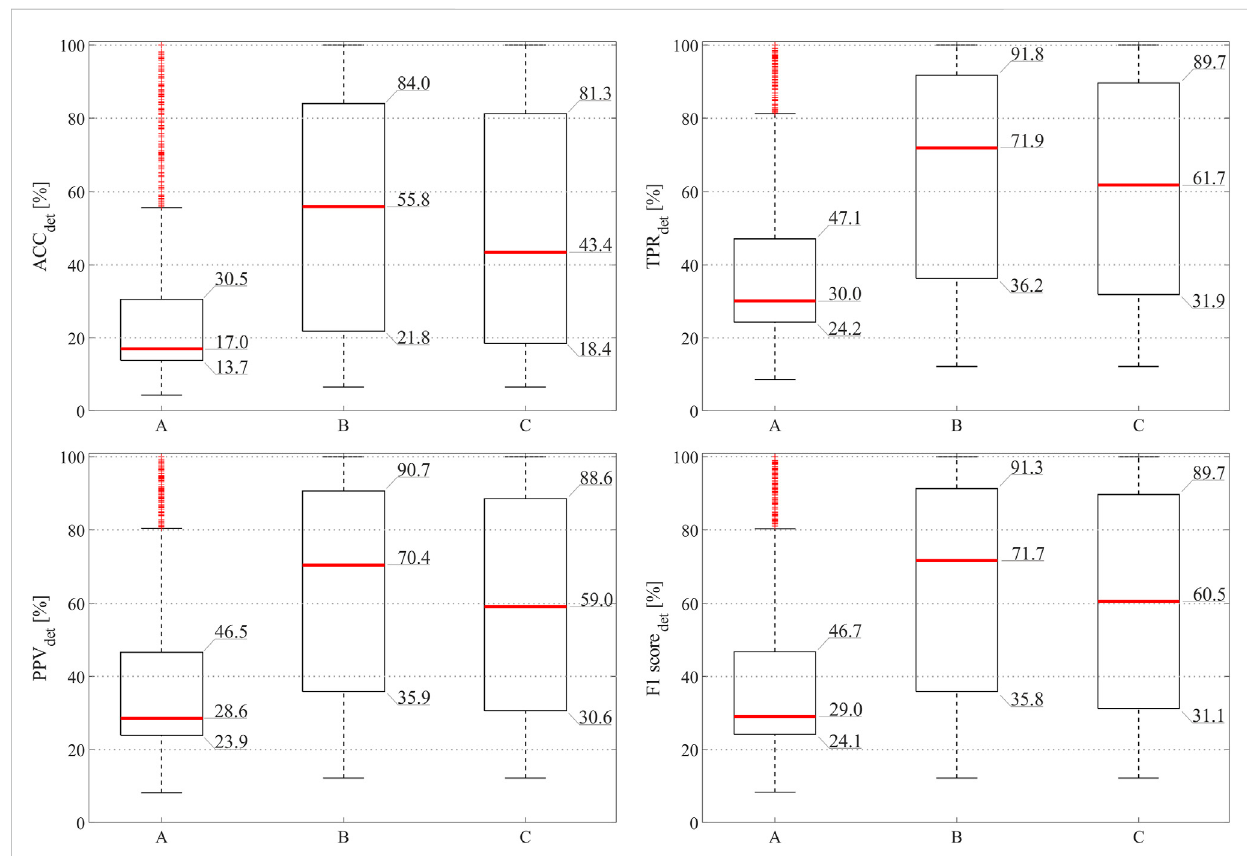
FIGURE 5 Fetal QRS detection results obtained by considering fECG signals extracted by all available abdominal channels (A) , by the abdominal channels identi fi ed as informative by the SQA-based approach exploiting all features (B) , and by the abdominal channels identi fi ed as informative ones by the proposed approach involving selected features only (C)